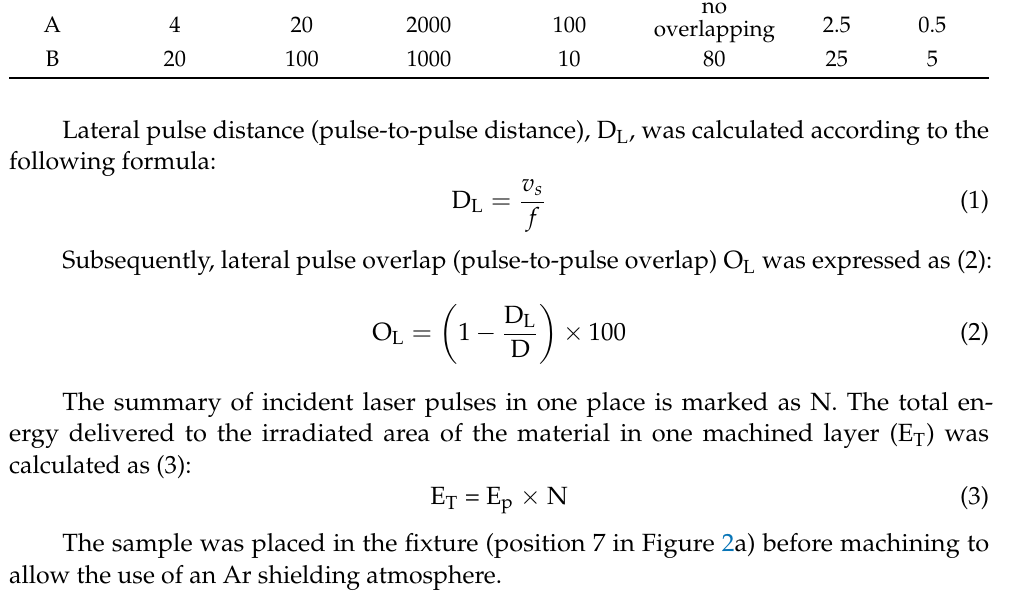
Table 2. Parameters of laser treatment.